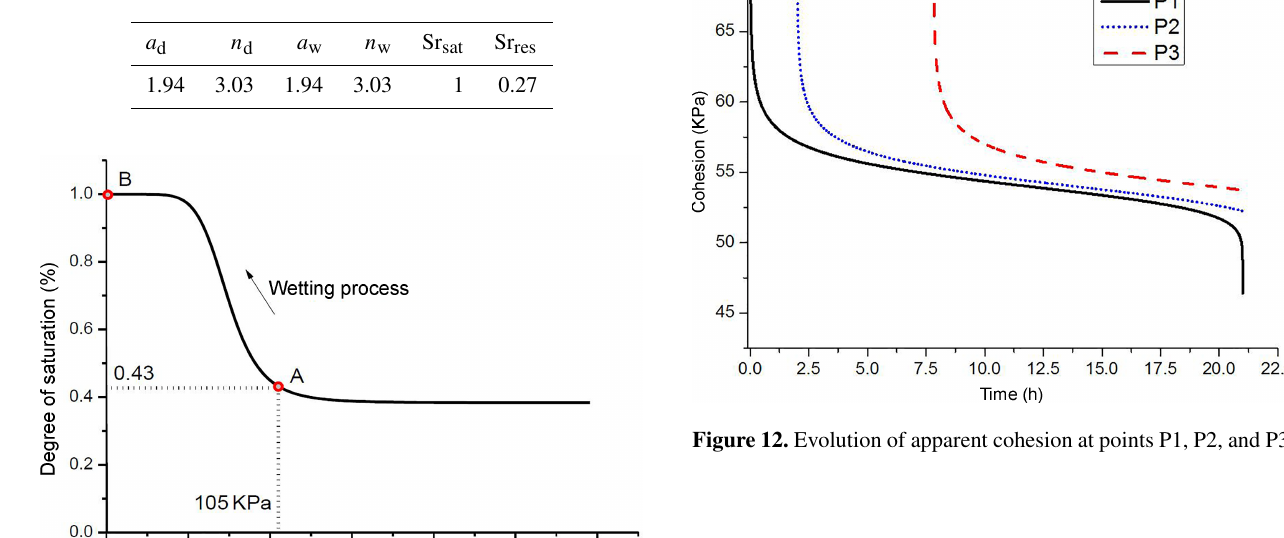
culated by Eq. (9a). Unstable zones first concentrate at ma- at points P1 and P2 indicates a slight decrease, and point